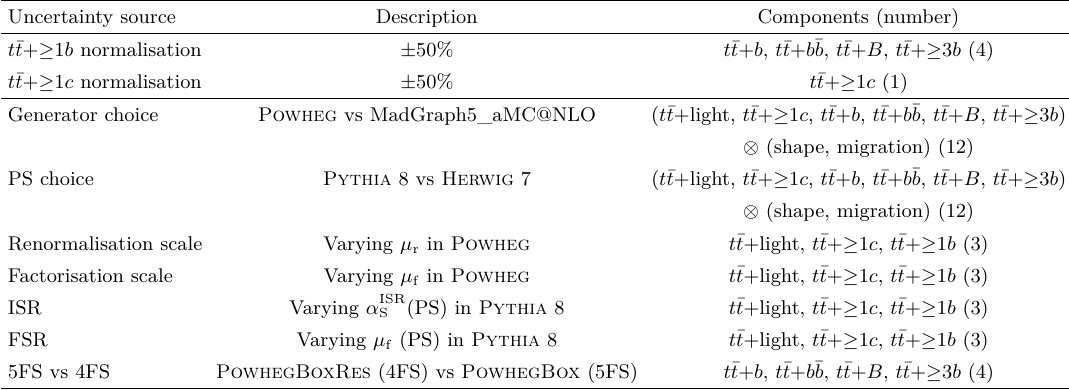
Table 2 . Summary of the sources of systematic uncertainty for the t ¯ t +jets modelling. The last column of the table lists the uncorrelated components of each systematic uncertainty source. All systematic uncertainty sources are treated as uncorrelated across the t ¯ t +jets components. For generator and PS choices, each t ¯ t +jets component is further decomposed into a shape component and a migration component. The number of uncorrelated components for each physics source is shown in